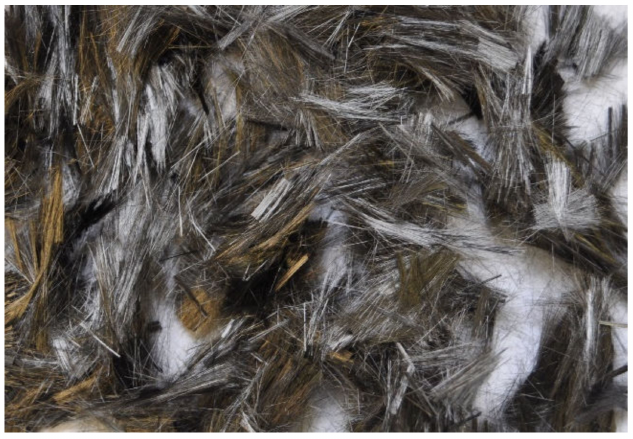
Figure 1. Short pitch-based carbon fibers used in various mortar